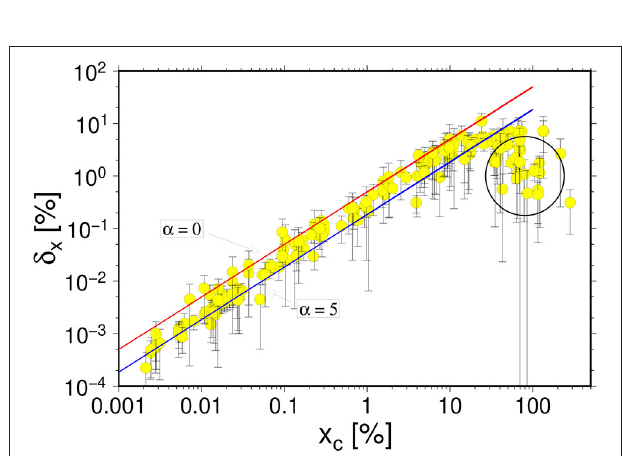
FIGURE 15 | The scatter plot of all analyzed events on the k n - b d plane. Different colors represent different categories of observed breaking mechanism: green—brittle, blue—hyper-elastic, yellow—semi-ductile, red—ductile, respectively. The star symbols depict cases for which the maximum of elastic energy is significantly delayed ( Ŵ > 5) with respect to the critical strain. For few cases we could not determine (for technical reasons) the delay parameter Ŵ and such cases are left as open (white) circles. The region of ( k n , b d ) parameters for which strong acoustic waves were observed is shaded in gray.